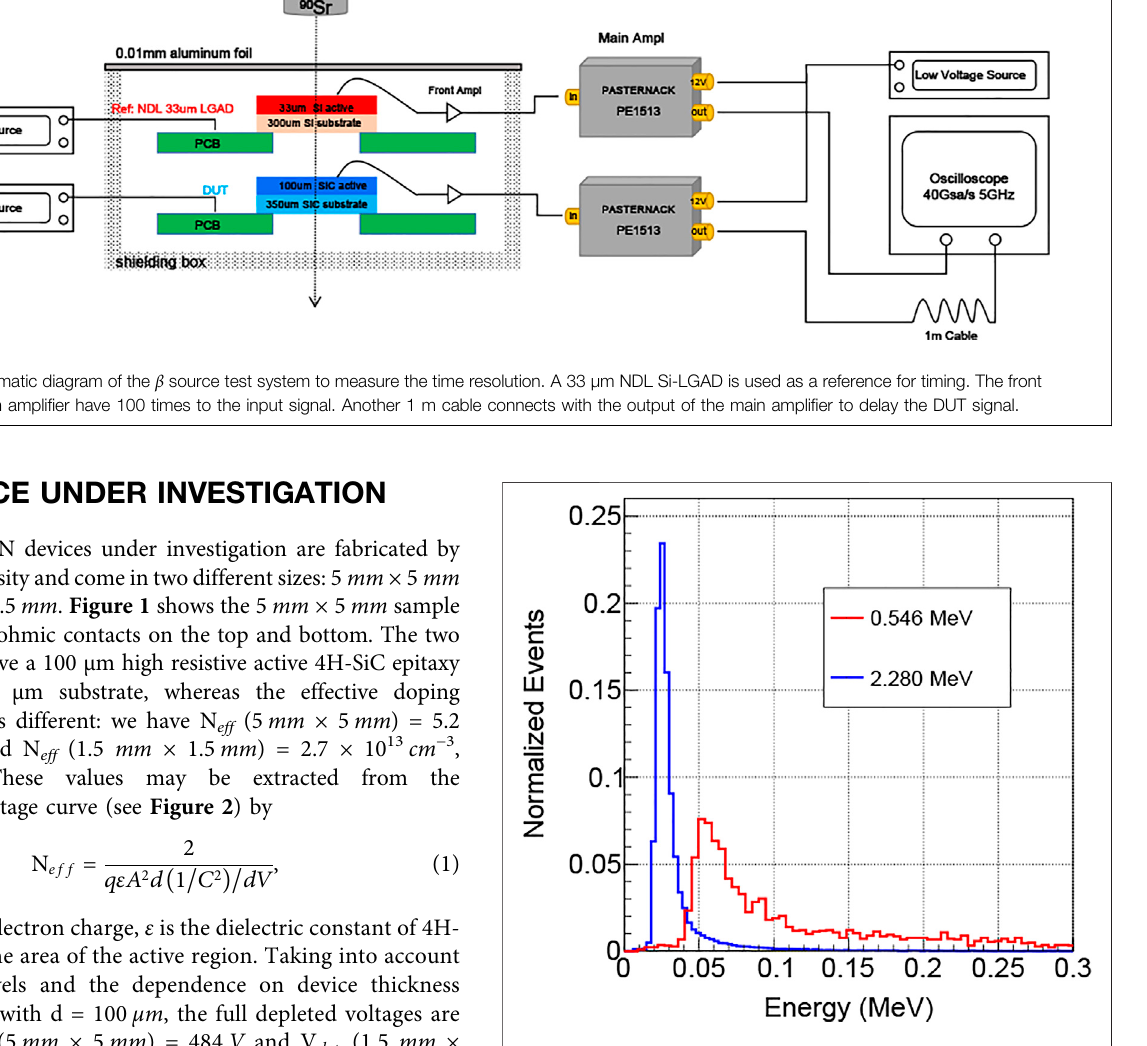
FIGURE 5 | Energy of β particles from the 90 Sr source deposited in the 100 μ m 4H-SiC PIN active layer after they pass the aluminum foil and LGAD in GEANT4 simulation. The 0.546 MeV β particles are from the 90 Sr decay and the 2.28 MeV β particles are from 90 Y